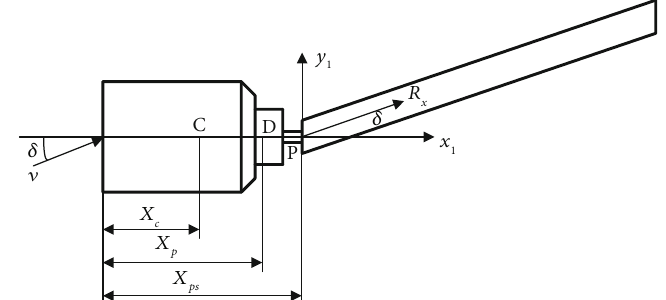
Figure 4: Analysis of the force on the ribbon.